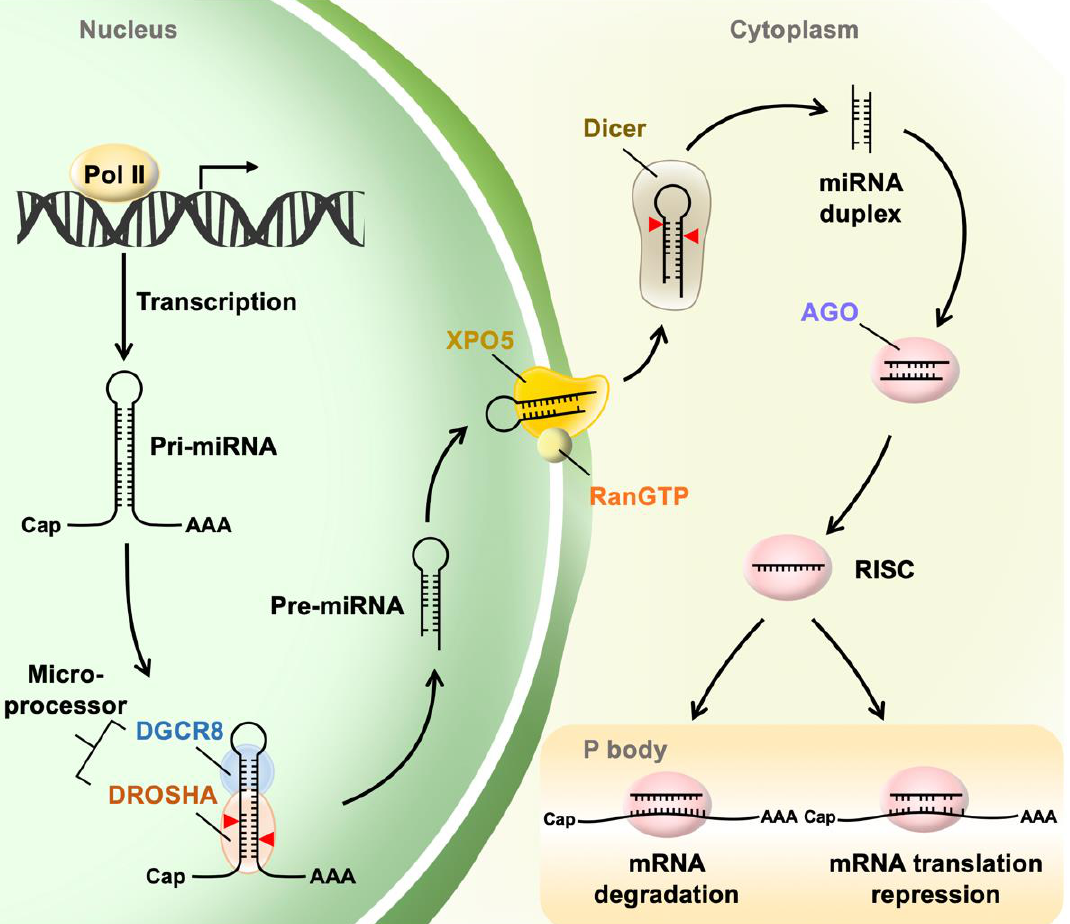
Figure 1. MicroRNA (miRNA) biogenesis. Primary miRNAs (pri-miRNAs) are transcribed by RNA polymerase II (Pol II) in the nucleus. The pri-miRNAs are cleaved by a microprocessor composed of Drosha and DiGeorge syndrome critical region 8 (DGCR8) to produce an approximately 70 nucleotide-long precursor miRNA (pre-miRNA) hairpin. Exportin-5 (XPO5) and the small nuclear GTPase RanGTP bind pre-miRNAs and assist the transport of pre-miRNAs into the cytoplasm, where they are further processed by Dicer to produce an approximately 22 nucleotide-long mature miRNA duplex. The guide strand of the mature miRNA is loaded into the RNA-induced silencing complex (RISC). The seed region of the guide strand targets the complementary 3′ - untranslated regions (UTR) of mRNAs and mediates gene suppression with targeted mRNA degradation (full complementarity) and translational repression (partial complementarity) in processing bodies (P-bodies).